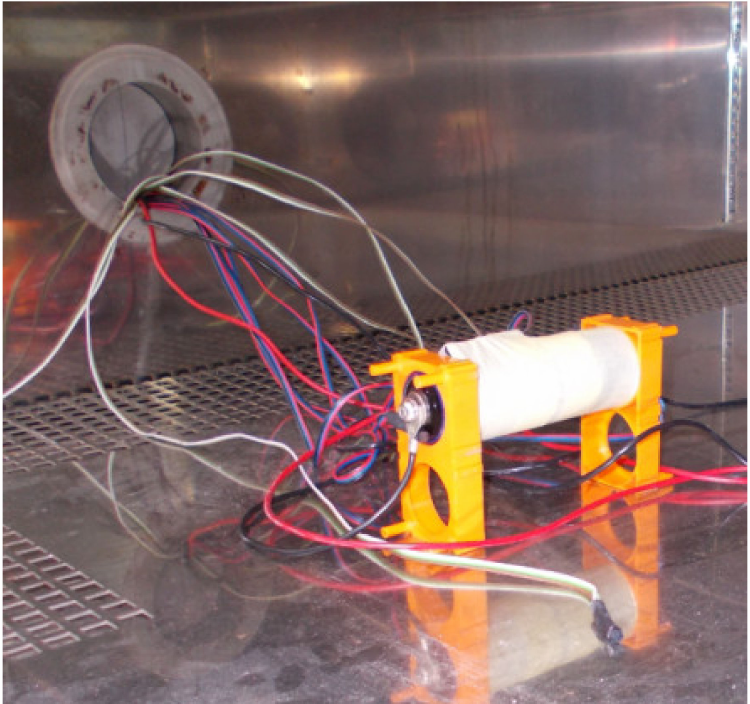
Figure 5. The climatic chamber stands for testing the influence of temperature on cell performance. For a fixed humidity equal to 75%, the ambient temperature was stepwise adjustable in the range from +5 ◦ C to +60 ◦ C. The load current was selected to be 3.8 A, which is around 40% of the standard discharge value. The influence of deteriorated cell cooling was examined in simulated conditions by wrapping the cell’s casing with appropriate thermal insulation and placing the whole in a styrofoam housing, as indicated in Figure 6.